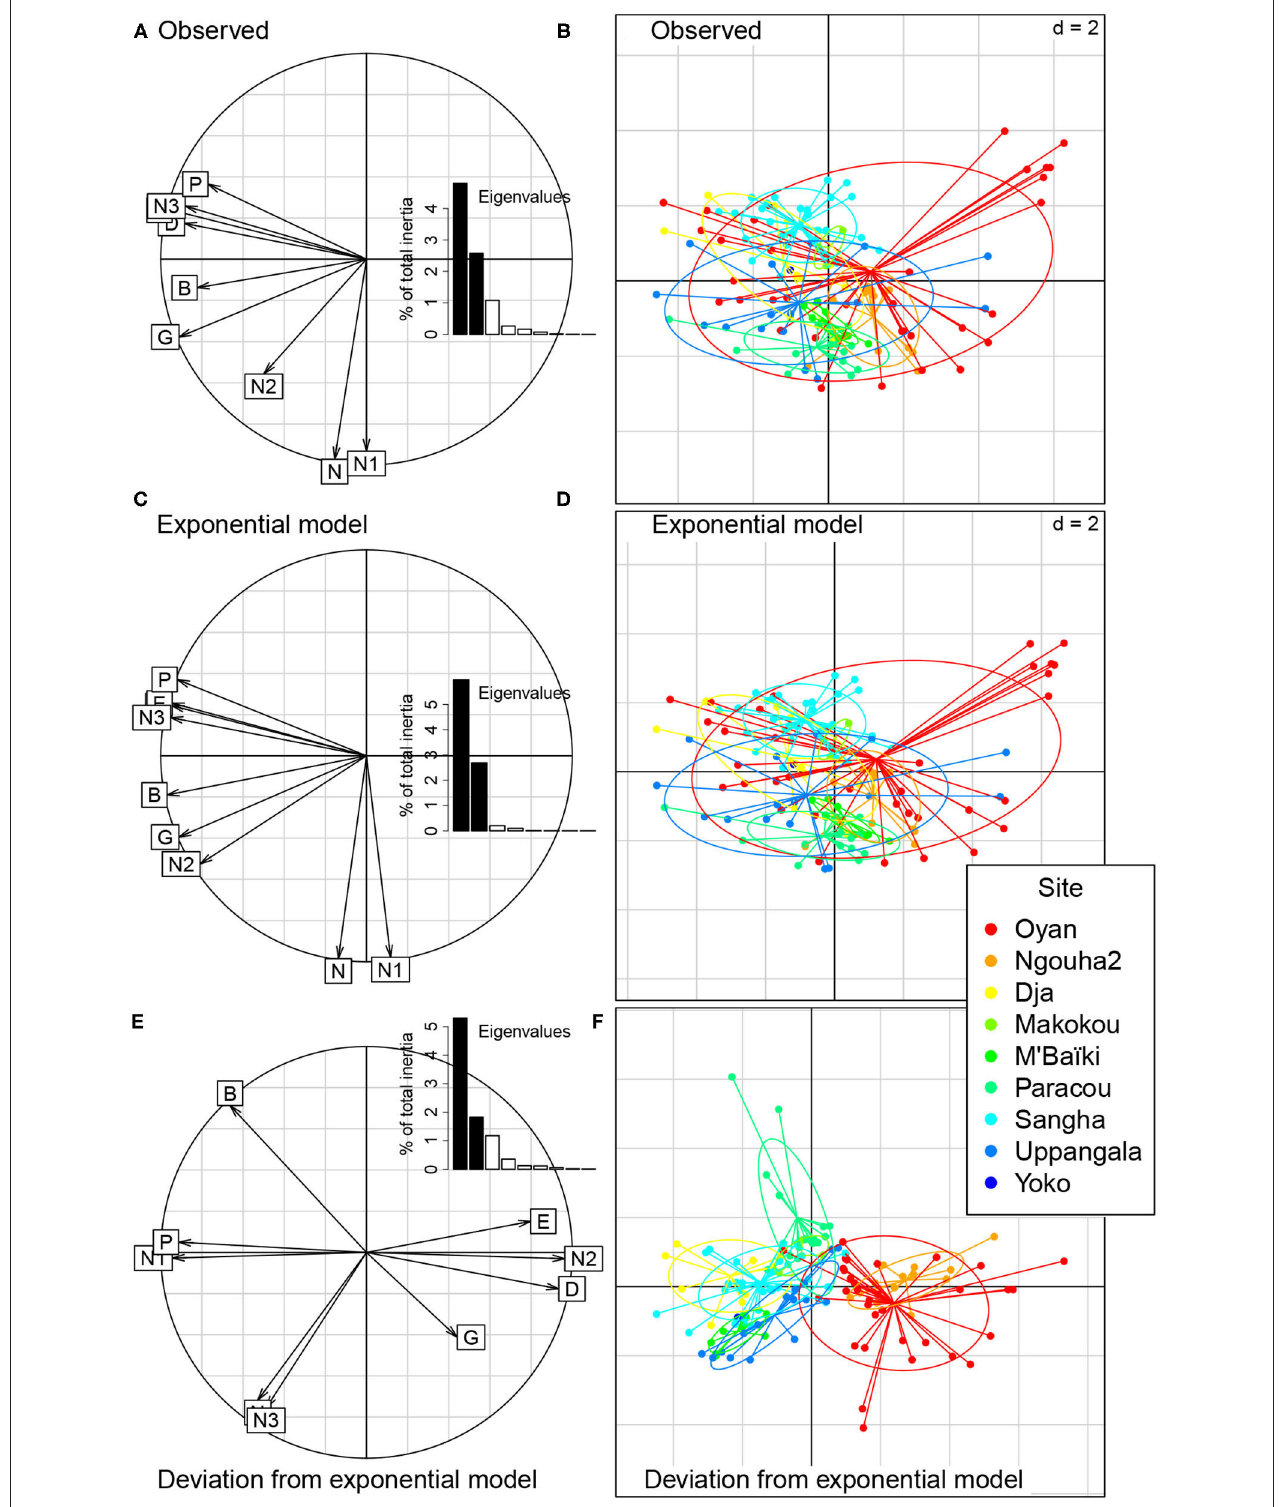
FIGURE 4 | Principal component analysis (PCA) of structural characteristics of 133 forest plots at nine sites. The PCA is performed either on the matrix of observed data (A,B) , on the modeled data using the exponential model (C,D) , or on the deviations of observations to the predictions of the exponential model (E,F)